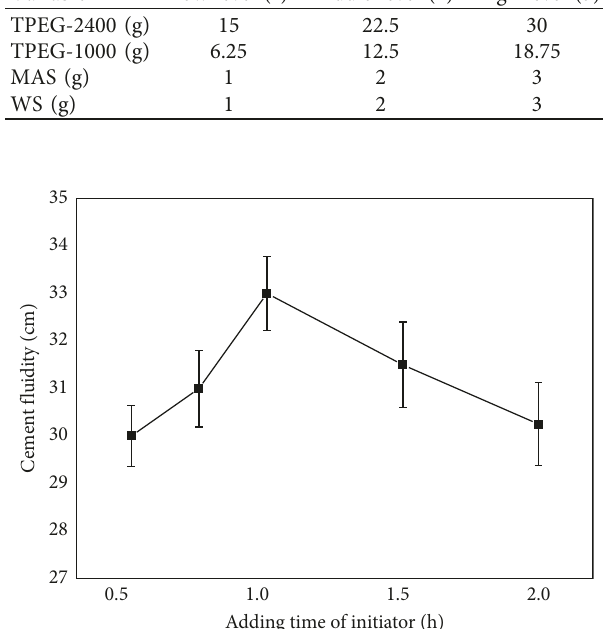
Figure 3: Effect of different adding time periods of the initiator on cement